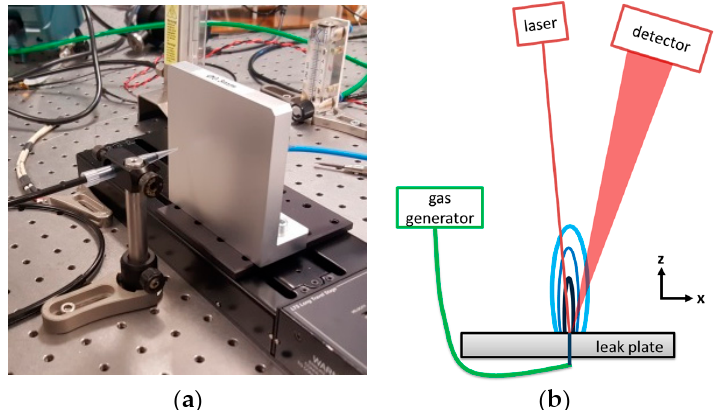
Figure 1. ( a ) Leak plate mounted on a linear displacement stage. The tip of an extractive sampling probe is positioned at 10 mm distance in front of the plate; and ( b ) the schematic setup for standoff leak detection.